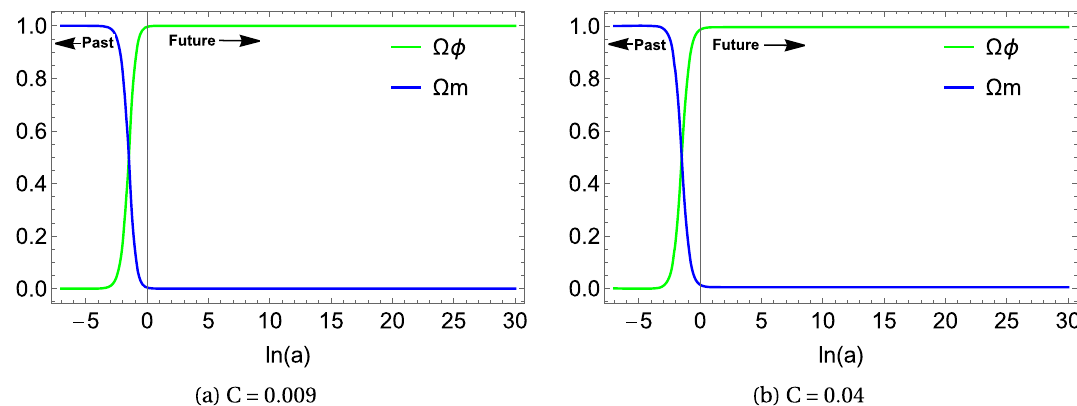
Fig. 9 The variation of density parameter (cid:12) φ and (cid:12) m for couplings C = 0.009 and C = 0.04 exhibiting no appearance of future